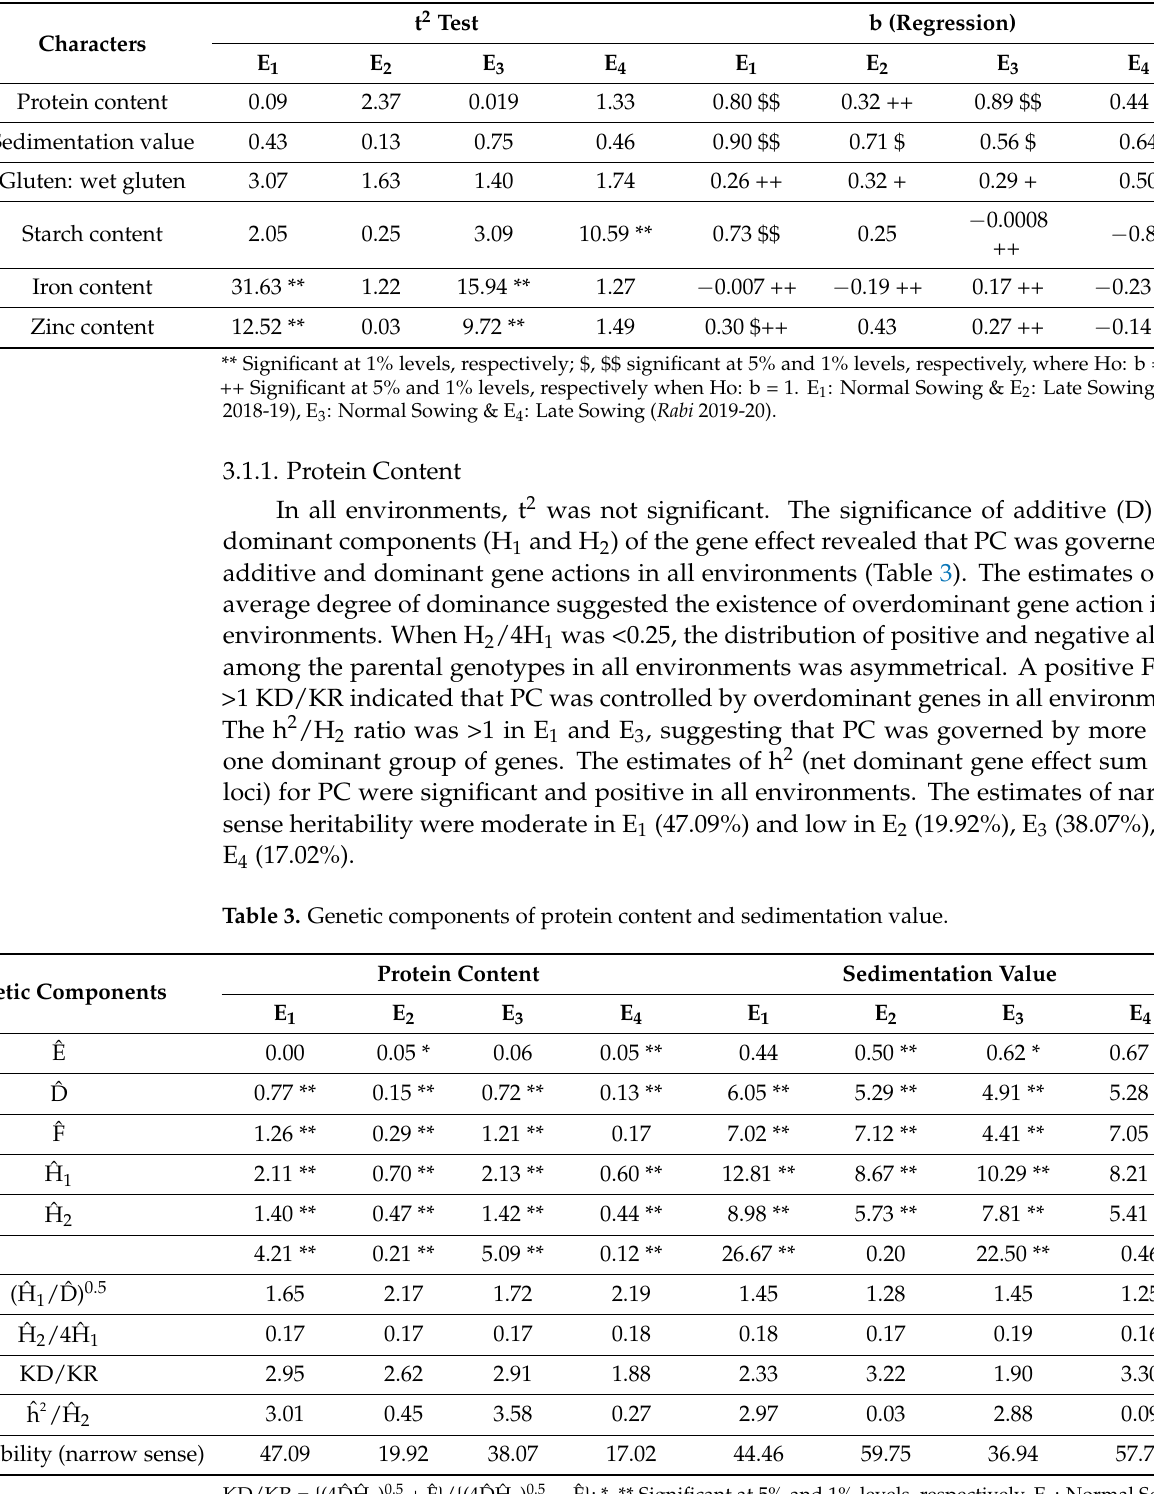
Table 2. t 2 and regression coefficient of different metric characters of Wr on Vr.